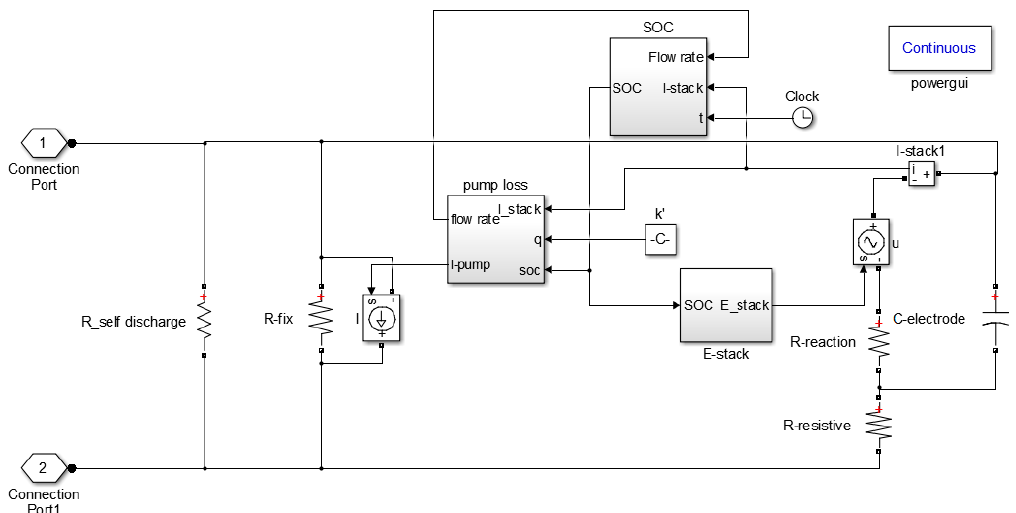
Figure 3. Generalized electrical model of zinc–nickel single-flow battery stack.